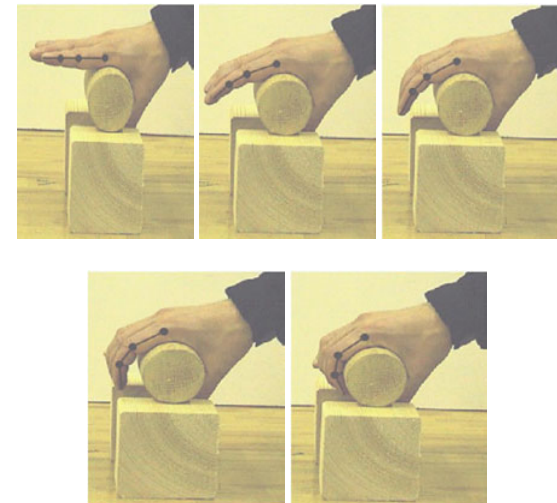
Figure 4 Photo sequence of a test of human grasping at LARM.